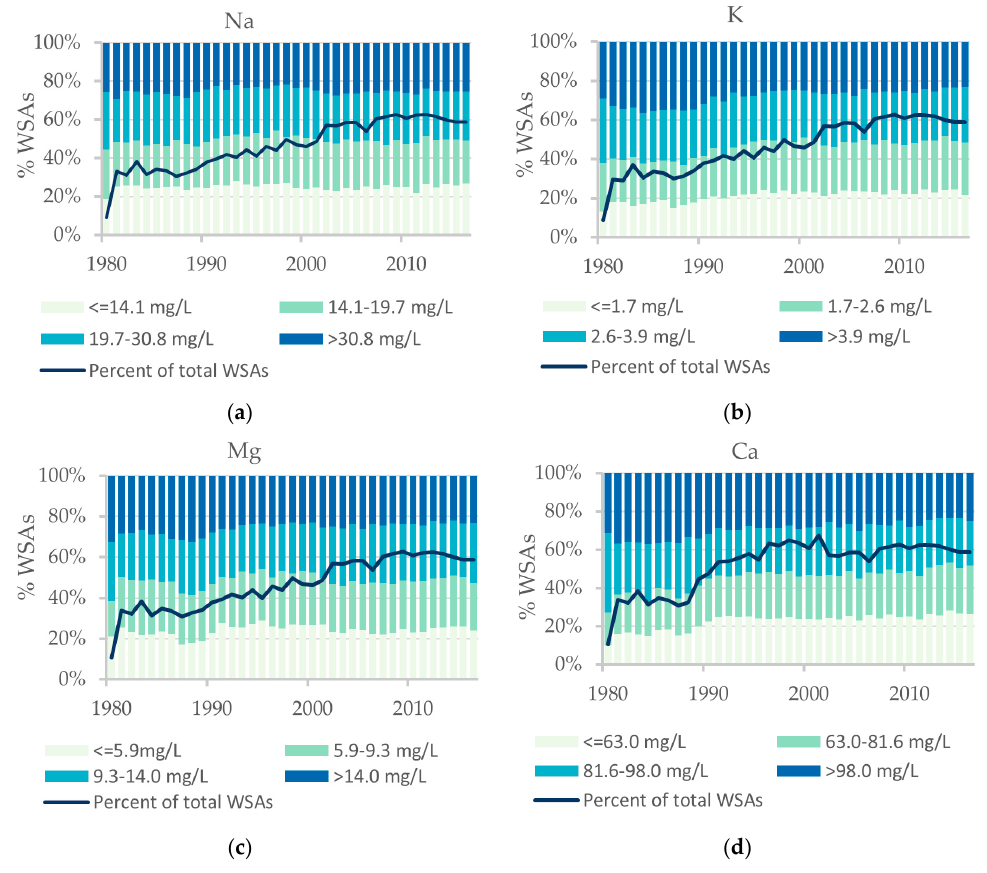
Figure 5. Temporal variations in yearly mean concentration at water supply area (WSA) level 1980–2016: ( a ) Na; ( b ) K; ( c ) Mg; ( d ) Ca. Concentration intervals are equal to quartiles of mean yearly concentration 2011–2015.